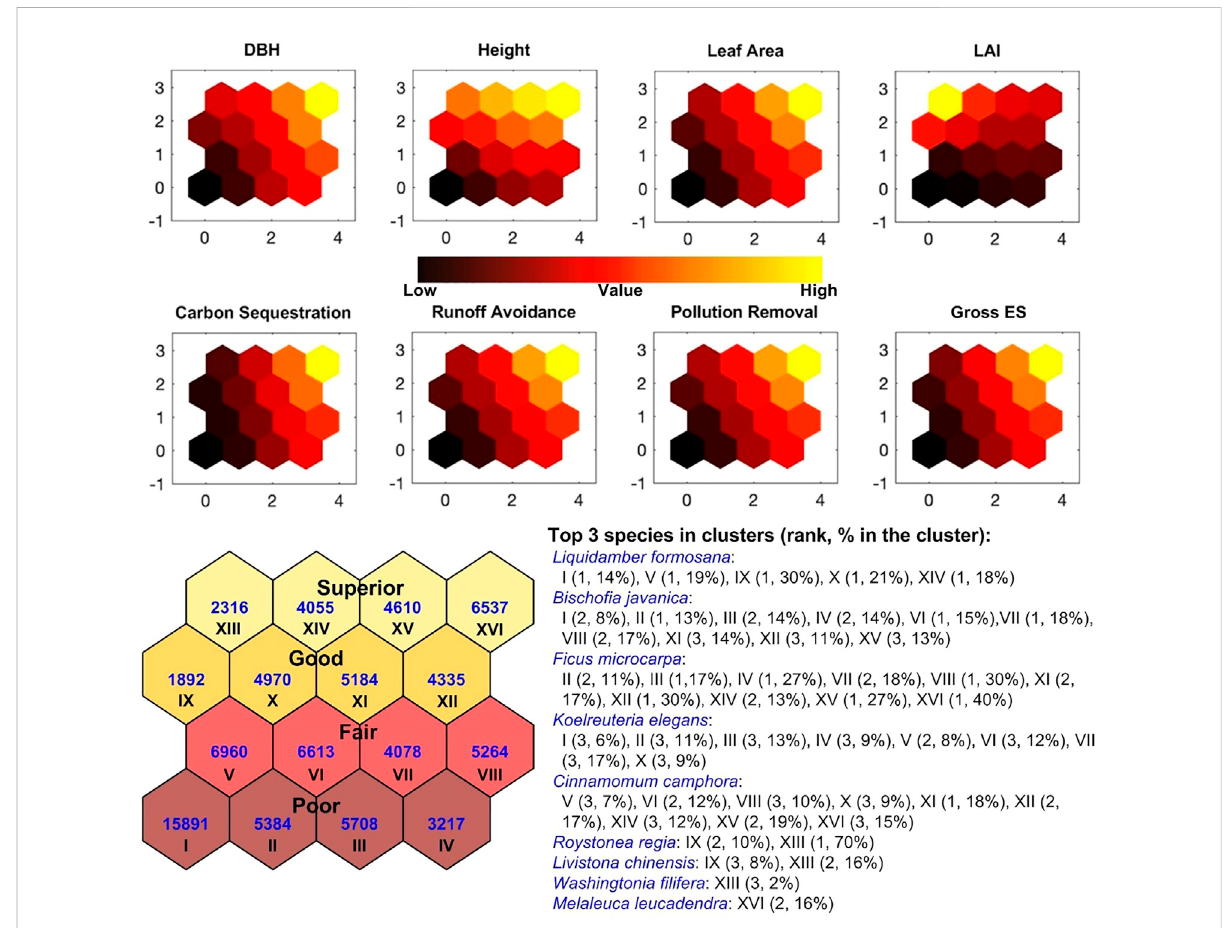
FIGURE 3 SOM map with 16 neurons (i.e., 4 × 4) representing associations of DBH, height, leaf area, and LAI, to the ES of carbon sequestration, runoff avoidance, pollutantremoval,andgrossES.Thelowerleftpresentedthere-classi fi cationintofourcategoriesofsuperior(yellow), good(orange),fair (red),andpoor(brown)grossESwith neuronnumbersoftheSOMfromItoXVI andthenumberofinput records(showninblue)ineachneuron.The lower right listed the top 3 species in the 16